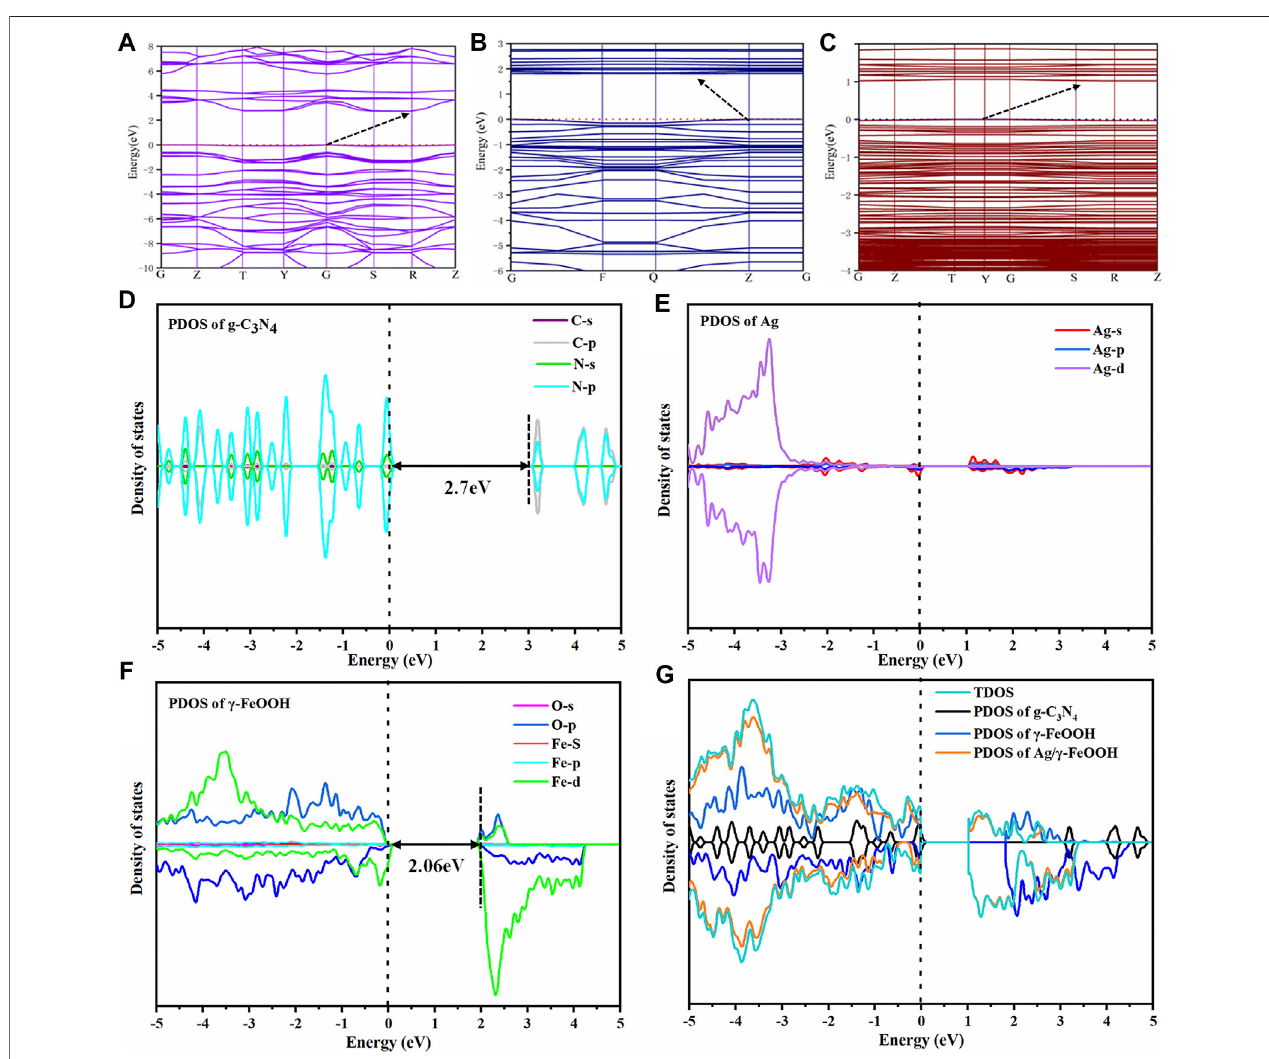
FIGURE 8 | (A) The energy band structure of pure g-C 3 N 4 , (B) the energy band structure of g-C 3 N 4 / γ -FeOOH, (C) the energy band structure of g-C 3 N 4 /Ag/ γ -FeOOH. (D – G) the PDOS and DOS of the catalysts.